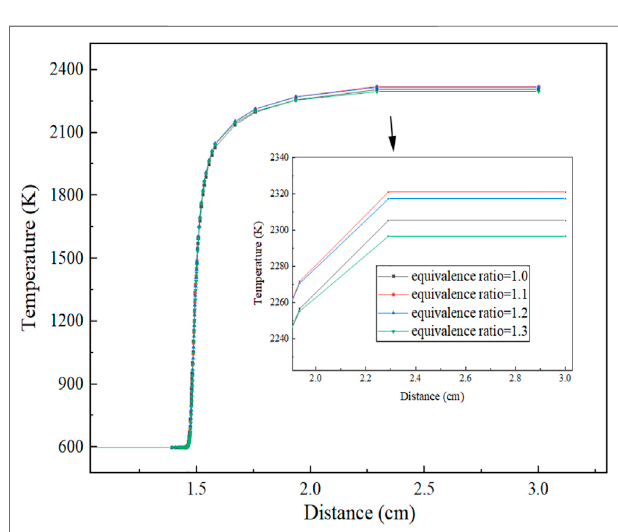
FIGURE 6 | Temperature distribution in oxygen-lean combustion.